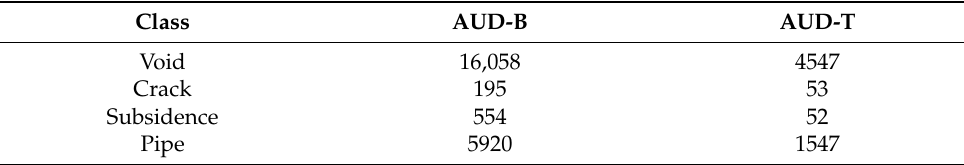
Table 1. Defect Number In Different